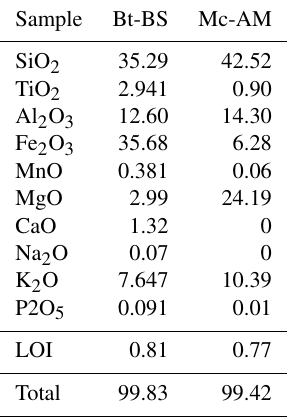
Table B2. X-ray fluorescence (XRF) analysis of mica used in our experiments (Bt-BS) and in Macente et al. (2018) (Mc-AM). Values are given in